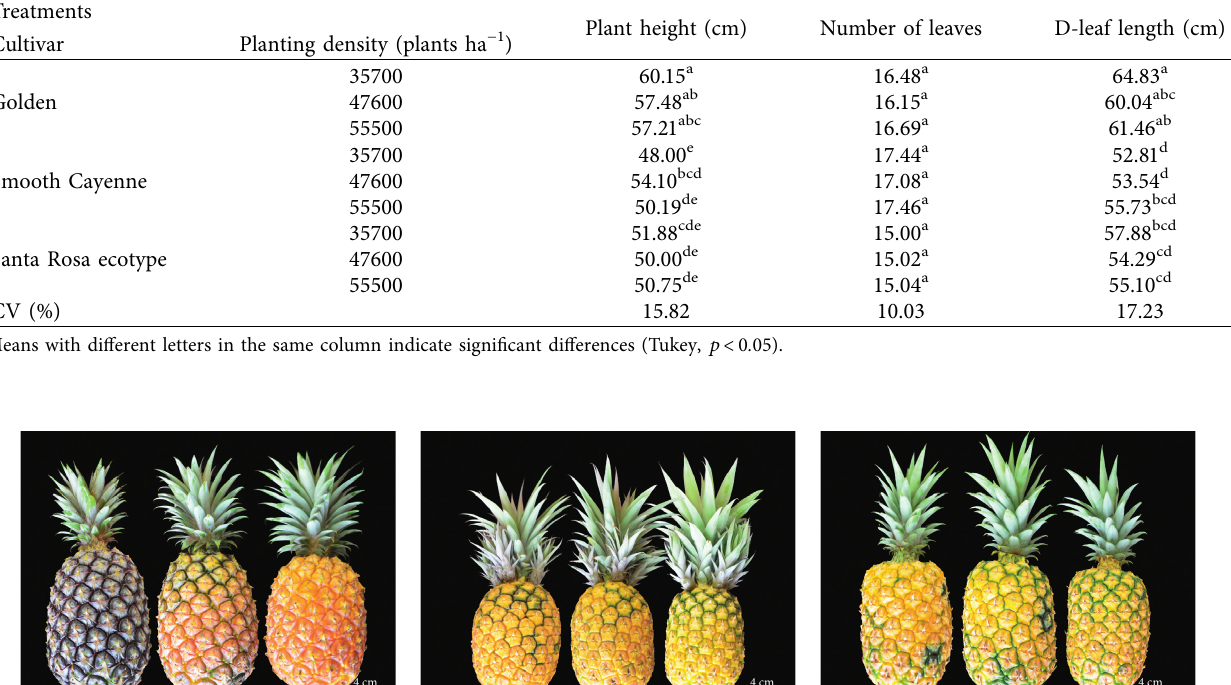
Table 1: Effect of sowing density on the growth parameters of three pineapple cultivars. Treatments